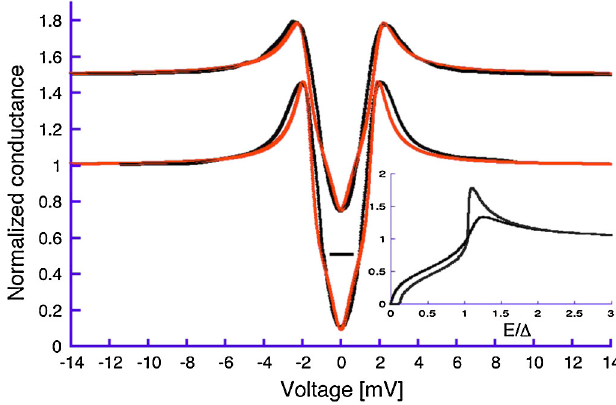
FIG. 5. (Color) In black, average conductance curves of EP (top) and vacuum baked (bottom) Nb samples, shifted for greater clarity. In red are fits with Shiba theory. Inset: Corresponding Shiba density of states. The figure is taken from Ref.